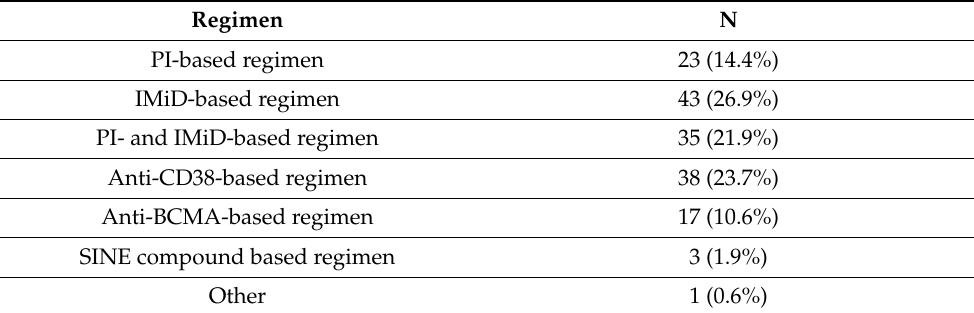
Table 2. Patients’ treatment combinations concerning multiple myeloma: Proteasome inhibitor